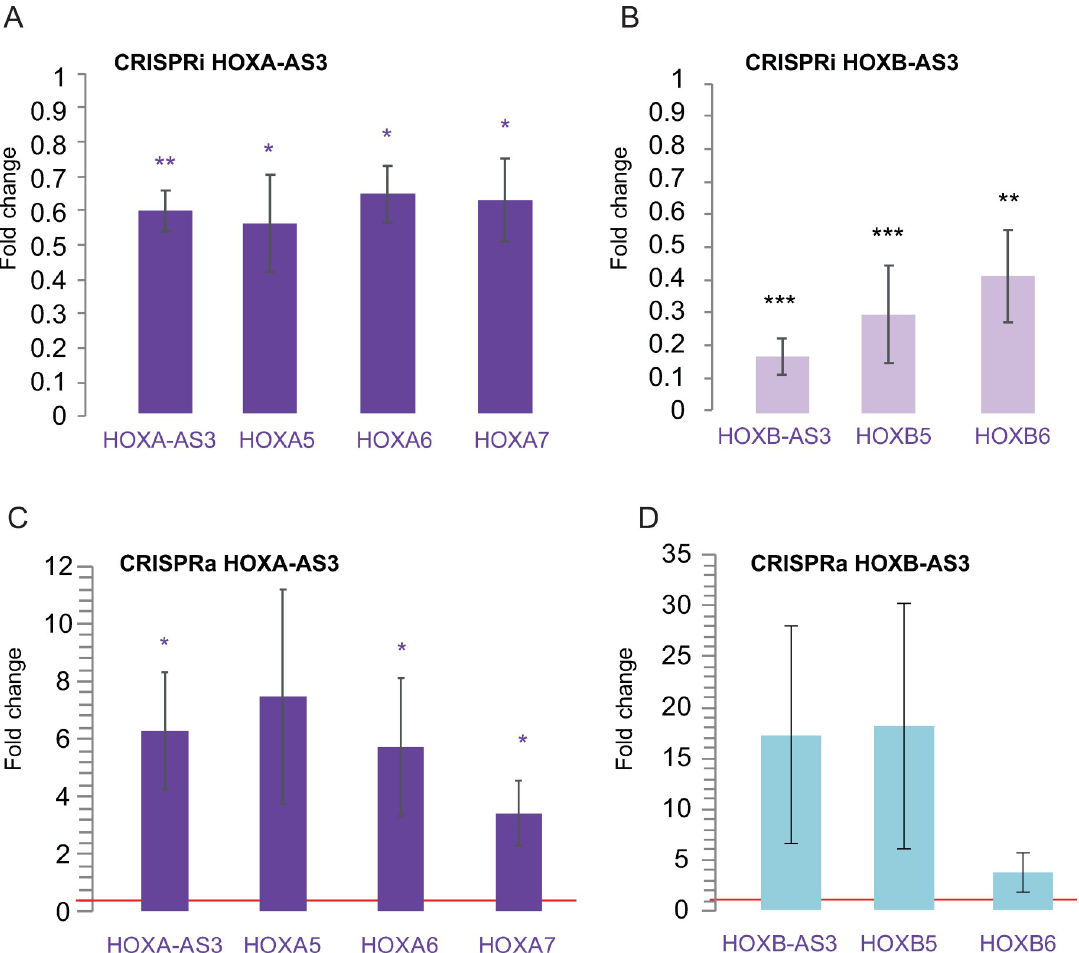
Fig 3. CRISPR inhibition and activation of HOXA-AS3 and HOXB-AS3 in HT-29 cells. (A) Changes in expression of the indicated genes is shown following inhibition of HOXA-AS3 . n = 4. ( B ) As in A, following inhibition of HOXB-AS3 . n = 4. ( C ) As in A, following activation of HOXA-AS3 . n = 4 ( D ) As in A following activation of HOXB-AS3 . Normalized to actin. Two-sided t-test. � —P < 0.05, �� — P < 0.005, ��� —P < 0.0005. Two-sided t-test compared to the transfection